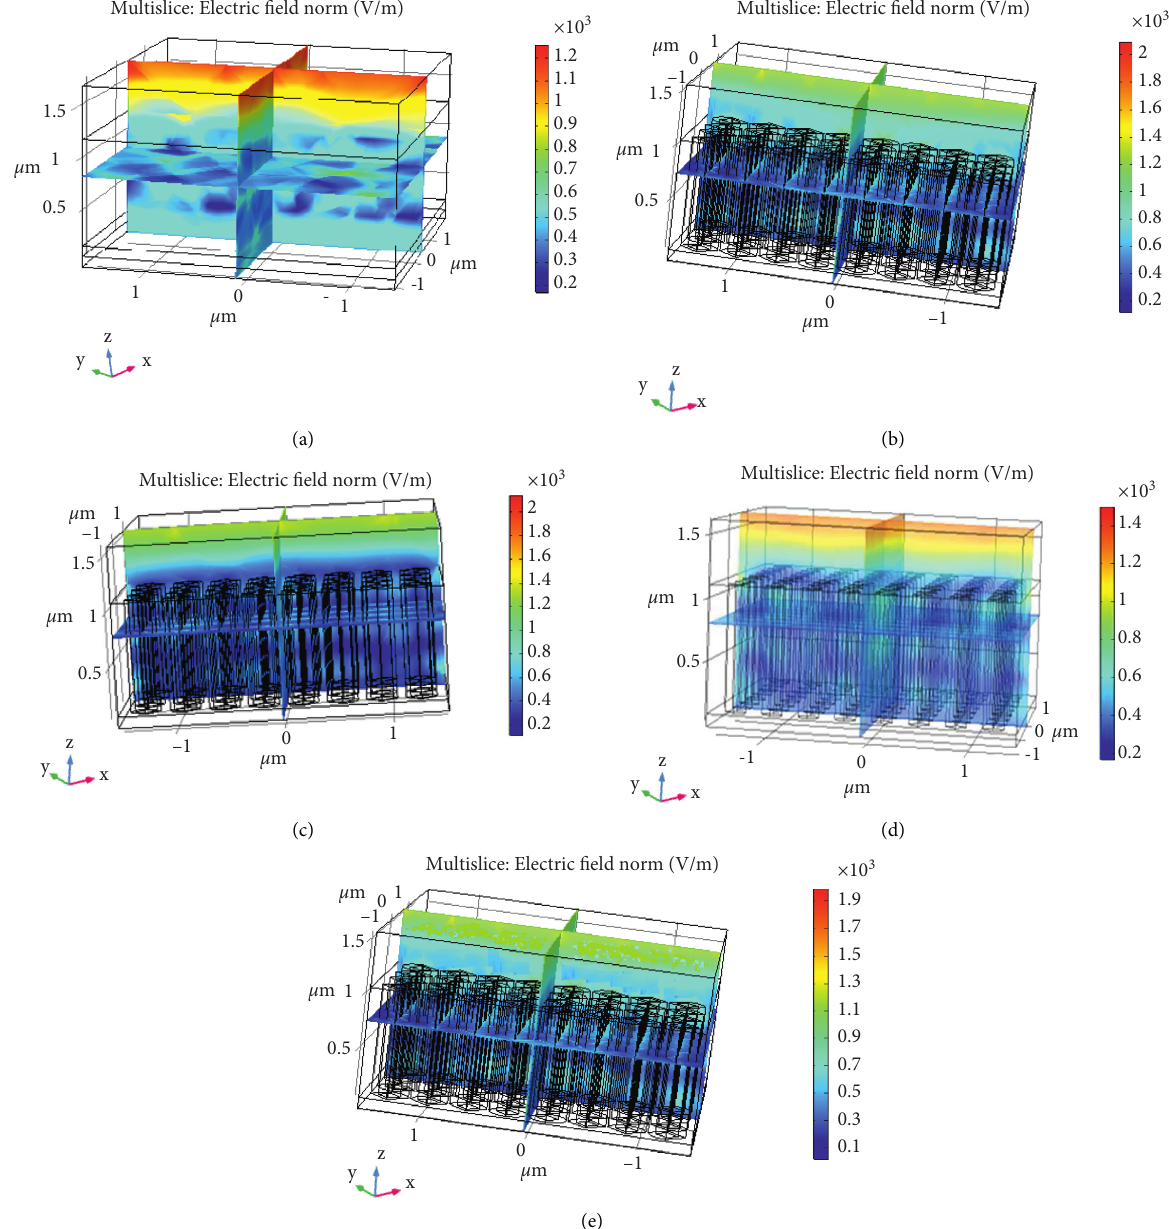
Figure 4: The electric field of (a) thin film, (b) CdS shell thickness of 30nm, (c) CdS shell thickness of 70nm, (d) CdS shell thickness of 0nm (without CdS shell thickness), and (e) CdS shell thickness of